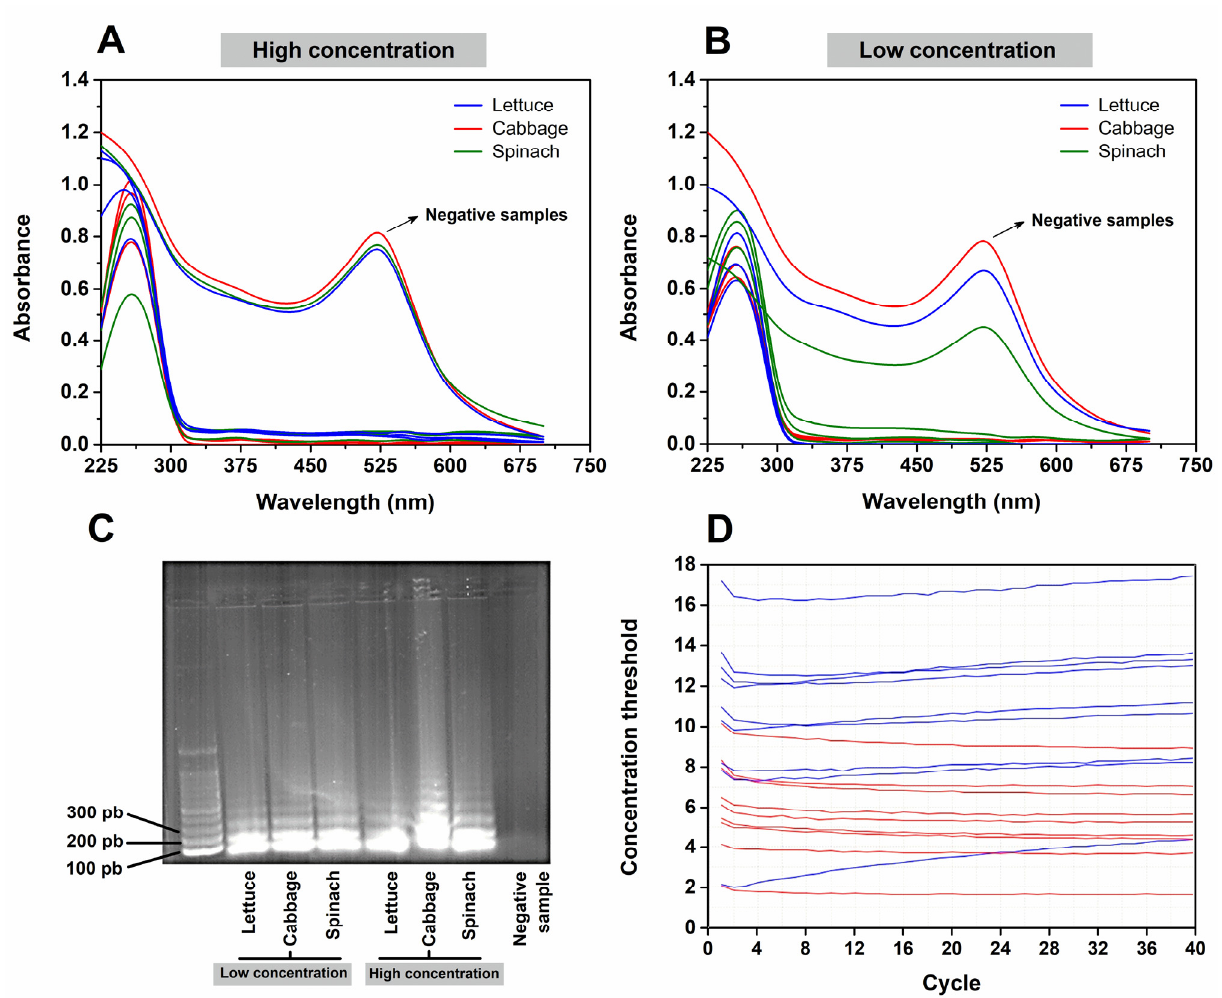
Figure 7. ( A , B ) The UV – Vis spectra after the application of the biosensor to detect SARS-CoV-2 at high (Ct:19) and low viral concentrations (Ct:31) in vegetables (lettuce, cabbage, and spinach), respectively. ( C ) Electrophoresis with 1% agarose gel to confirm RNA amplification in vegetable samples. ( D ) Image generated by RT-qPCR, showing that there was no detection in the samples subjected to the RNA extraction.